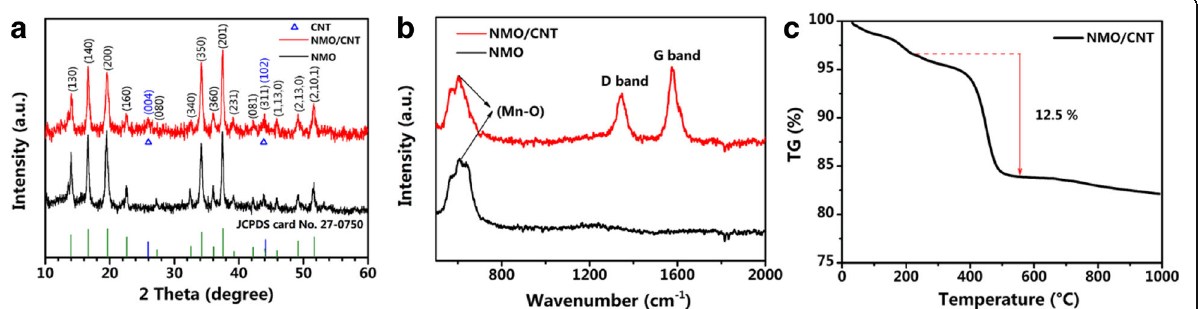
Fig. 2 a XRD patterns of NMO/CNT and NMO. b Raman spectrum of NMO/CNT and NMO. c TG curves of the NMO/CNT composite at a heating rate of 10 °C/min under